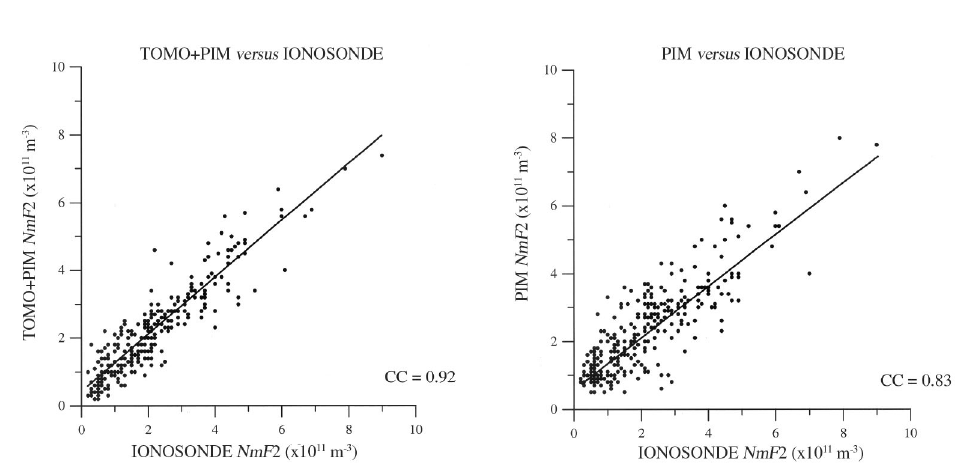
Fig. 8.13. Correlation of NmF 2 from tomography plus PIM maps ( left panel) and PIM alone maps ( right pan- el) with corresponding values from ionosondes (from Dabas and Kersley, 2003, reproduced by permission of the American Geophysical